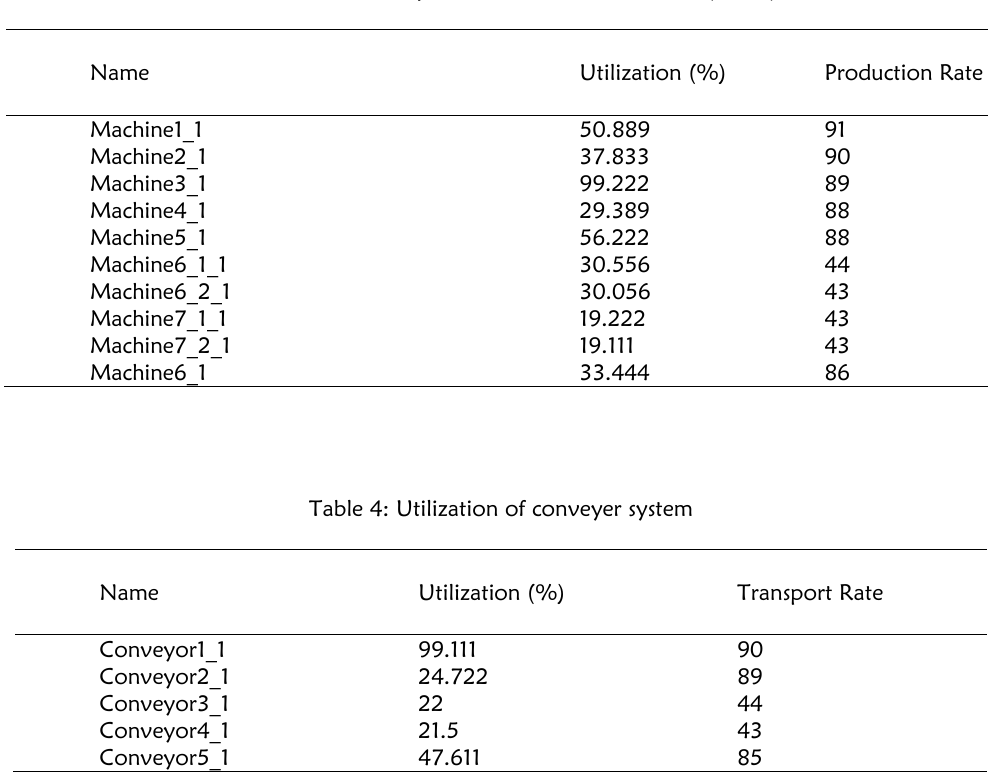
Table 3: Utilization and production rate for the conveyer’s system